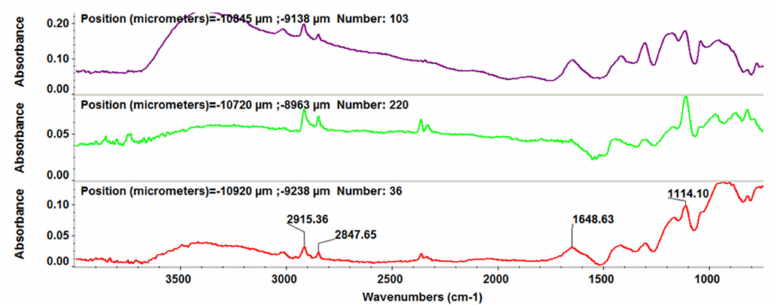
Figure 13. IR spectra recorded for bare Fe 3 O 4 @ β -CD thin films deposited at F = 400 mJ/cm 2